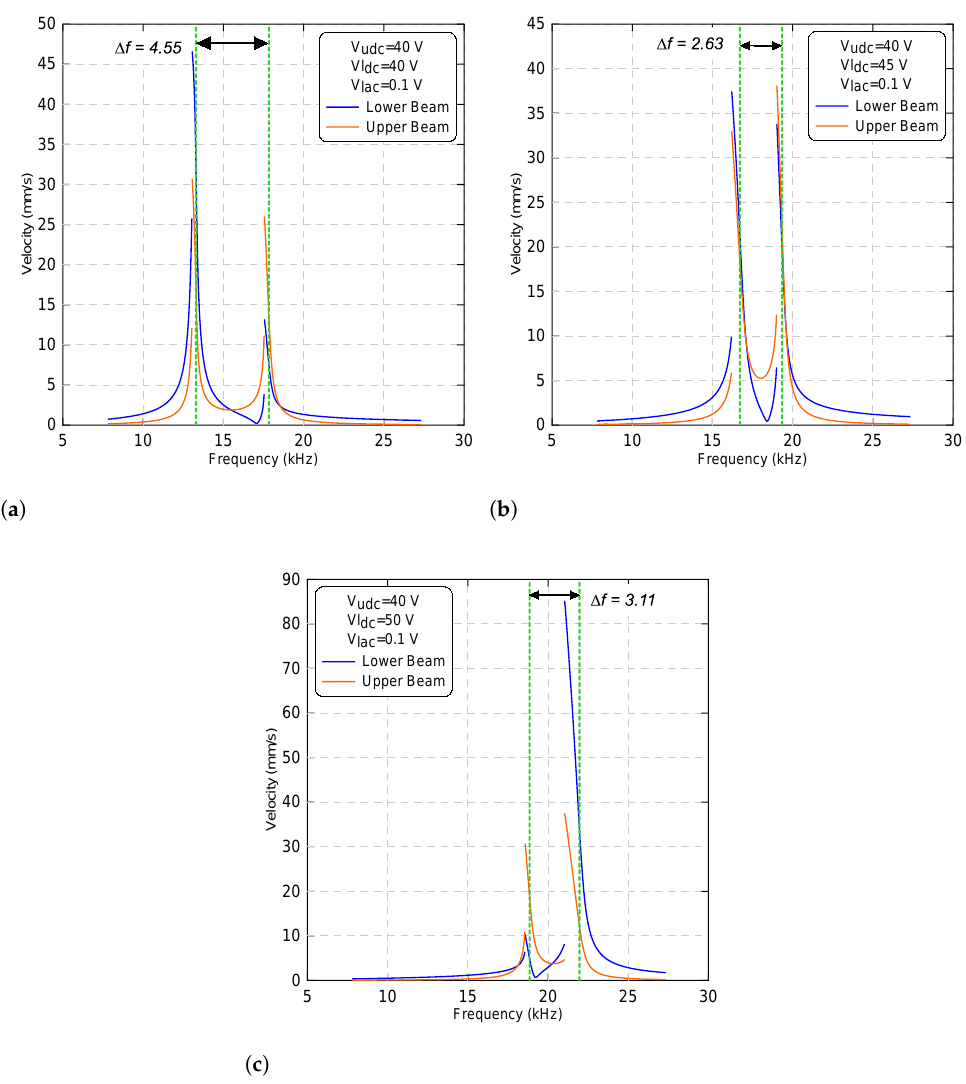
Figure 7. The frequency-response curves of the lower beam resonance frequency f l 1 and of the upper beam resonance frequency f u 1 with an upper voltage sets to V udc = 40 V and lower voltage sets to: ( a ) V ldc = 40 V, ( b ) V ldc = 45 V and ( c ) V ldc = 50 V. The lower harmonic voltage V lac is set to 0.1 V. The lower beam results are marked with blue lines and the upper beam results are marked with orange